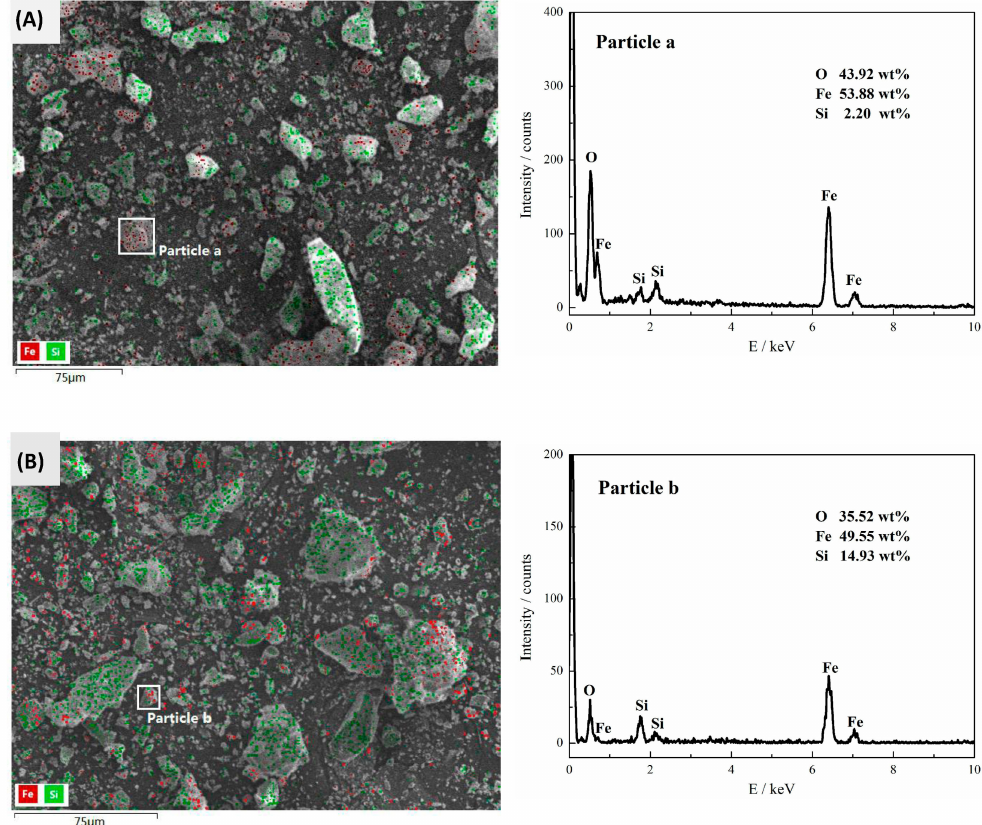
Figure 10. SEM photomicrographs with EDS: ( A ) flotation tailings with collector SFA; ( B ) flotation tailings with collector